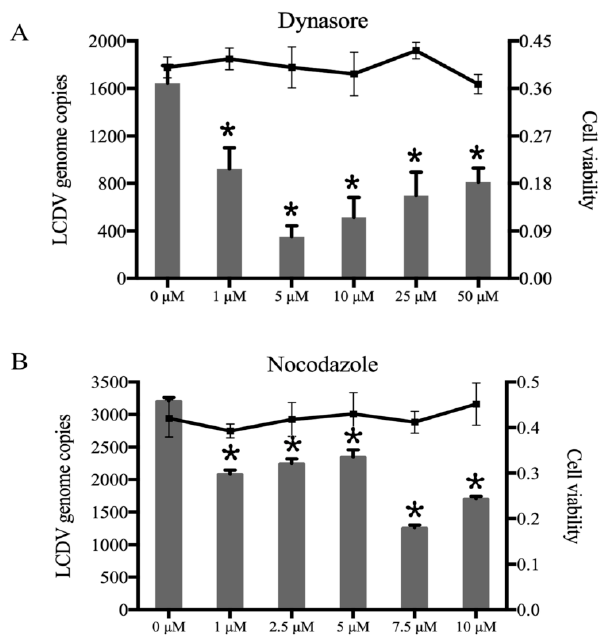
Figure 3. LCDV entry depends on dynamin and microtubules. ( A ) FG cells were pre-incubated with dynasore, and then infected with LCDV. LCDV copy numbers were detected by qPCR; the histogram represents virus copy numbers and the line graph represents cell viability. ( B ) FG cells were pre-incubated with nocodazole and then infected with LCDV. LCDV copy numbers were detected by qPCR; the histogram represents virus copy numbers and the line graph represents cell viability. FG cells pre-incubated with DMSO instead of dynasore or nocodazole served as negative controls. Error bars ( A , B ) represent SD ( n = 3). Asterisks denote significant differences compared with negative controls ( p < 0.05, one-way ANOVA).